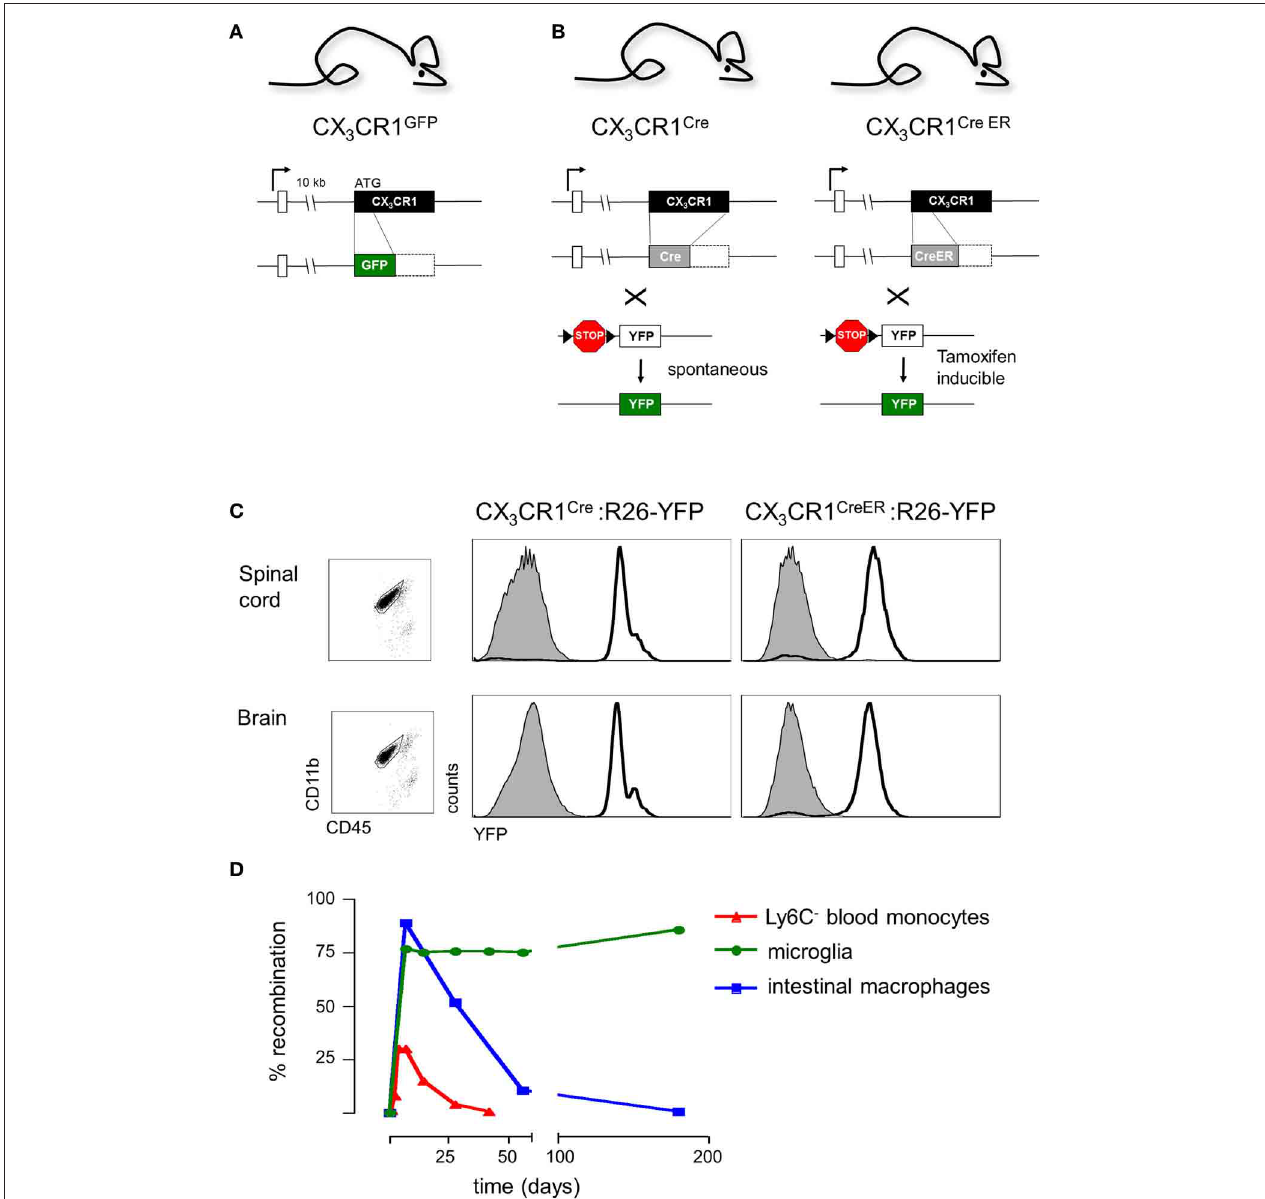
FIGURE 3 | (A) Schematic of modified CX 3 CR1 loci of CX 3 CR1 gfp mice (Jung et al., 2000) and (B) CX 3 CR1 Cre and CX 3 CR1 CreER mice (Yona et al., 2013); (C) Efficient YFP labeling of both spinal cord and brain microglia in CX 3 CR1 CreER and CX 3 CR1 Cre mice crossed with R26-YFP reporter mice. CX 3 CR1 CreER :R26-YFP mice were